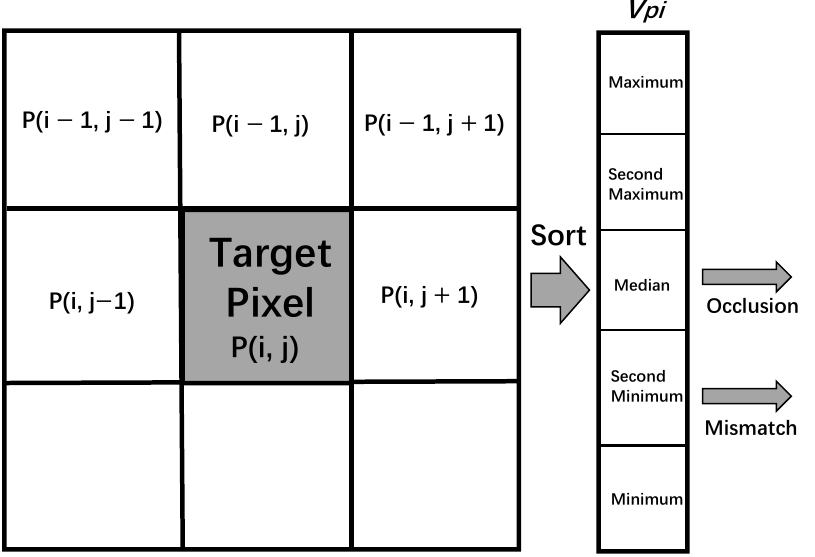
Figure 6. Valid values for occlusion and mismatch.